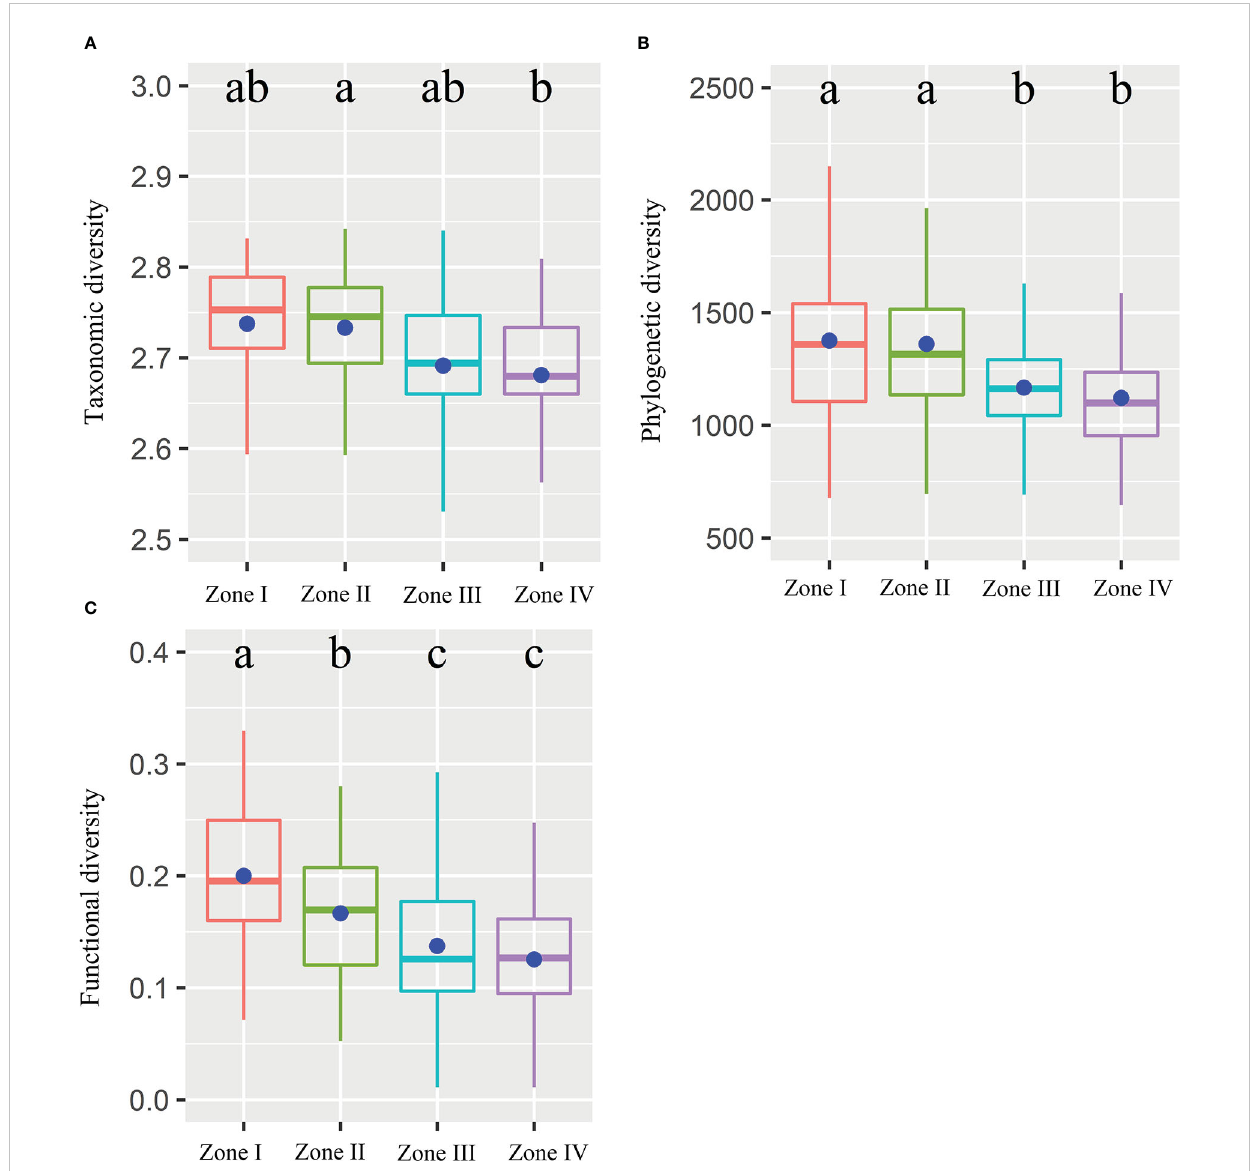
FIGURE 2 Taxonomic (A) , phylogenetic (B) , and functional (C) diversity within four inundation gradients within the reservoir riparian zone regulated by the Three Gorges Dam in China. Boxes present the median, 25th, and 75th percentile. The blue dots of boxes represent the average values. Different letters are used to mark signi fi cantly distinct values between inundation gradients based on the Kruskal-Wallis test (p <